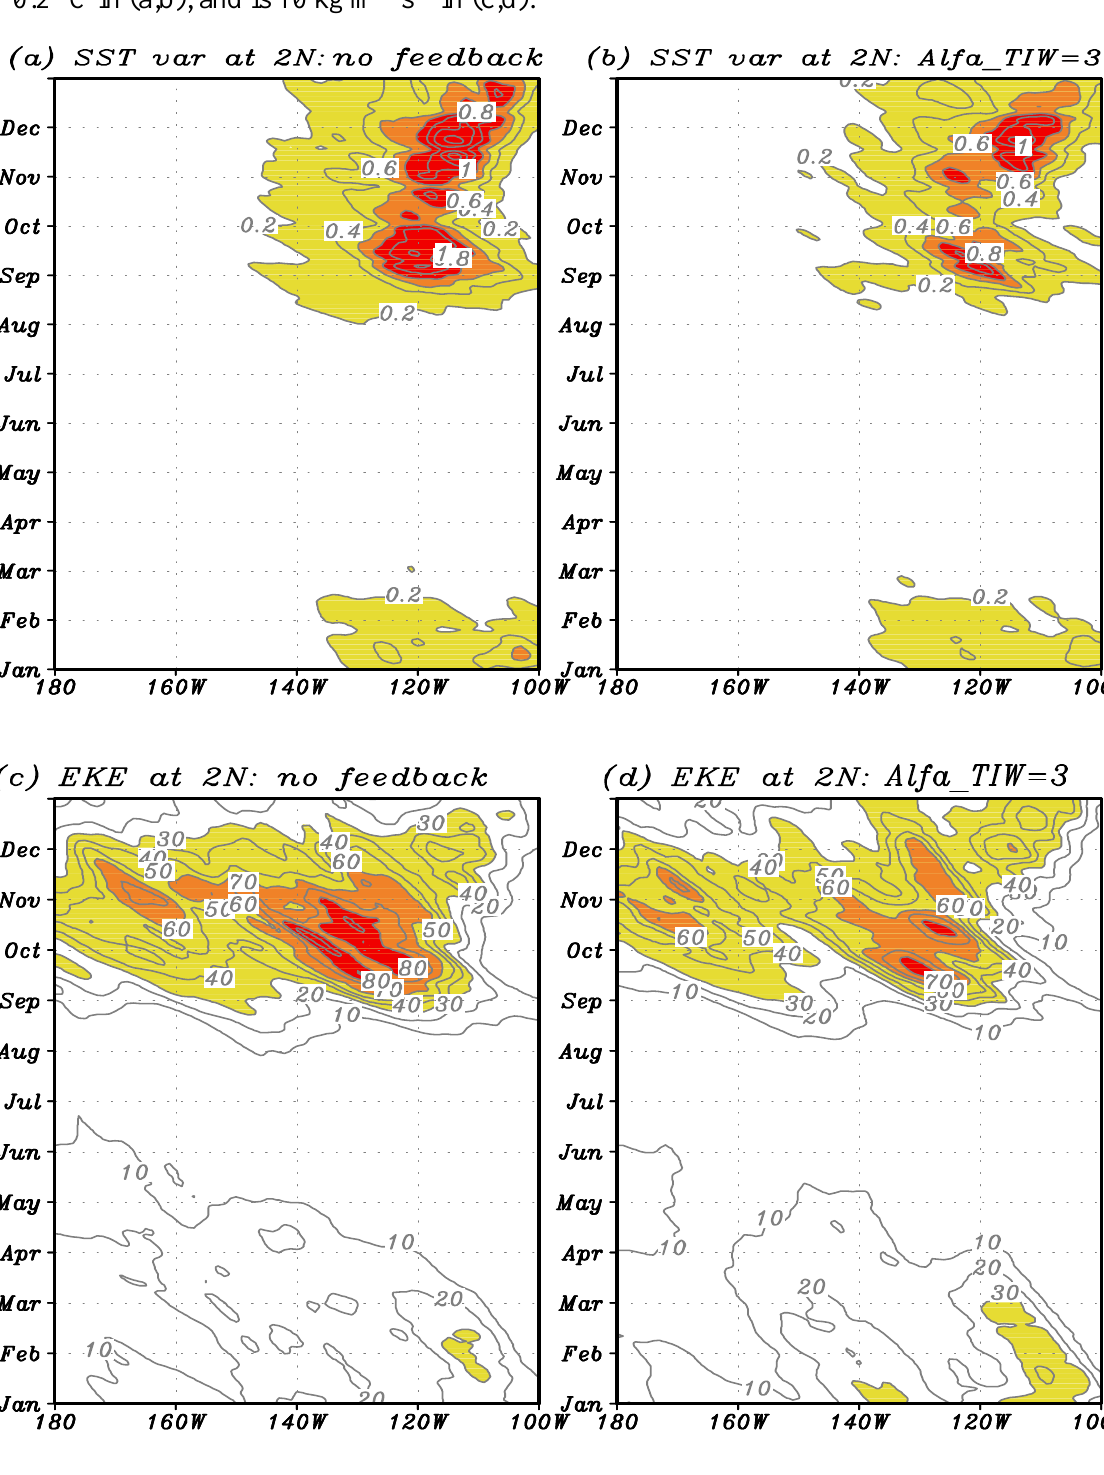
(upper panels) and of the TIW